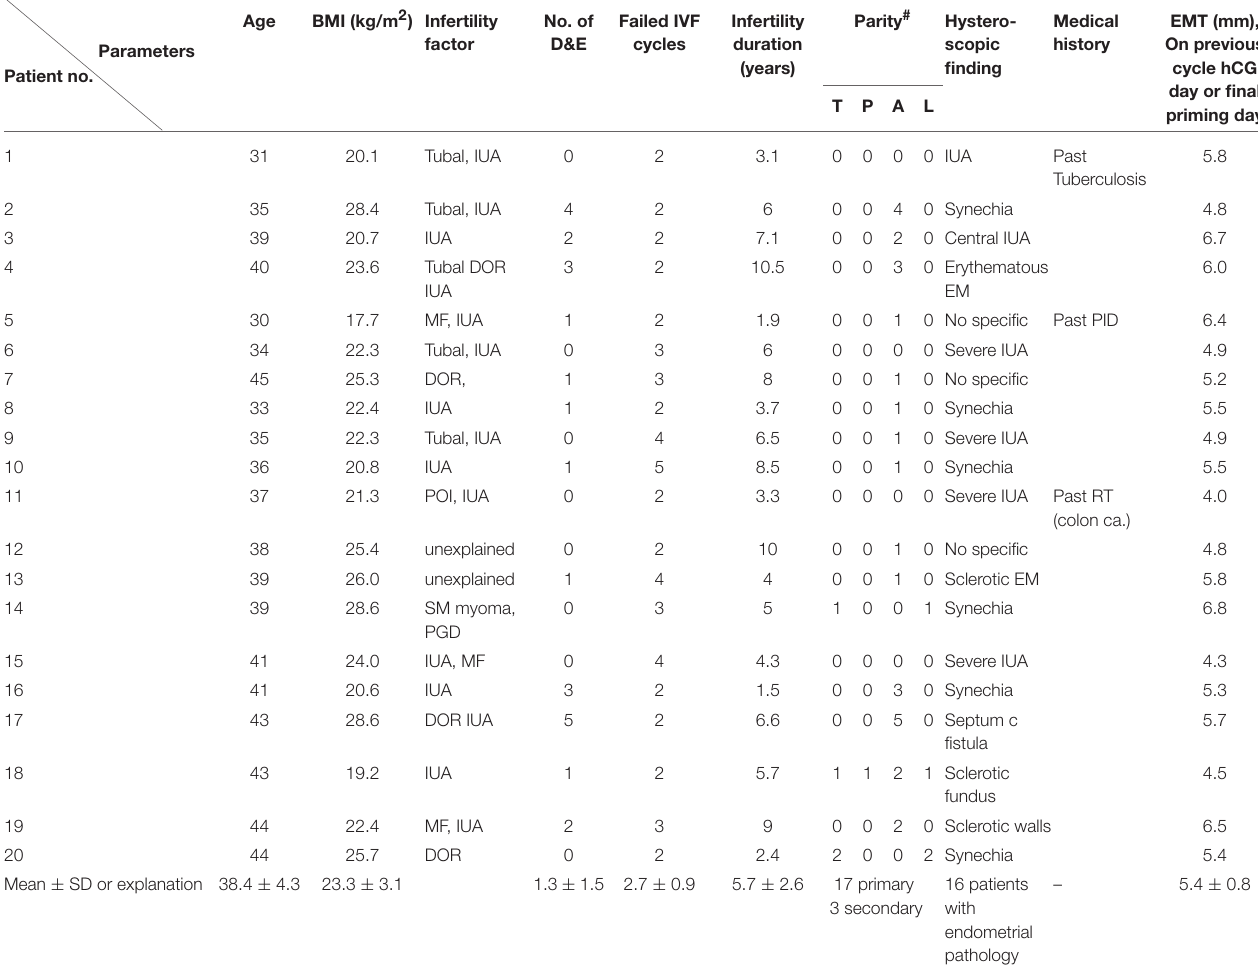
Age BMI (kg/m 2 ) Infertility